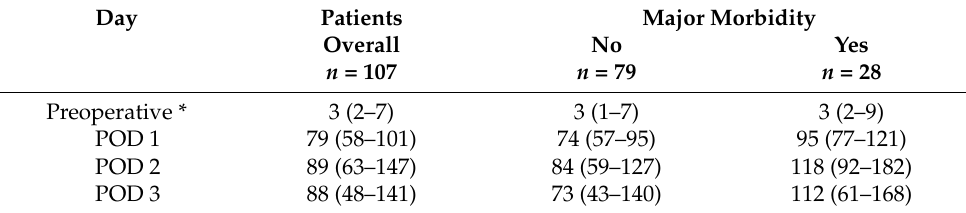
Table 5. CPR levels at the preoperative and early postoperative